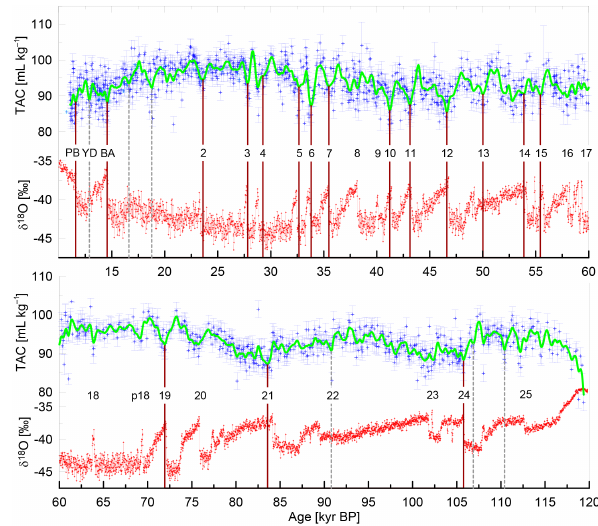
Figure 9. The significant minima in the TAC spline with 750-year cutoff from 10 to 120ka BP. The measured TAC on AICC2012 gas age scale is blue; the spline is green. Minima marked by ruby lines are considered significant by the algorithm described in the text, while significant minima without a close-by DO event are indicated by grey dashed lines. Red: the δ 18 O ice on the AICC2012 ice age